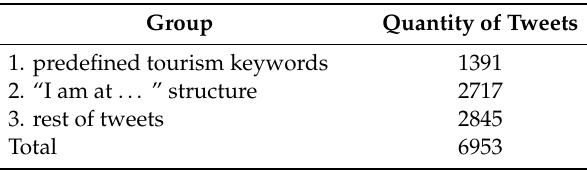
Table 2. Quantity of tweets in each tweet group